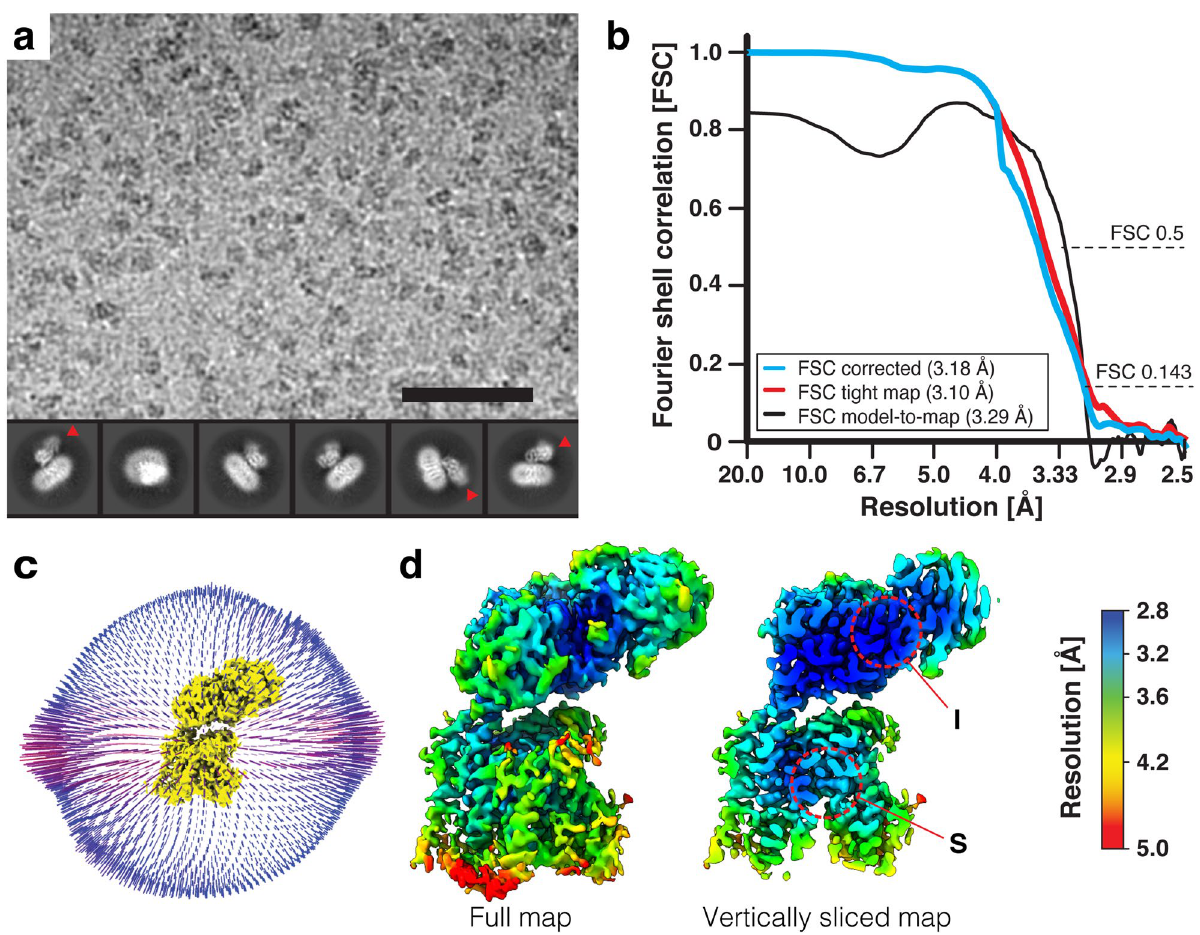
Figure 2. Cryo-EM structure determination of human 4F2hc-LAT2::D11vs. ( a ) In the upper part, a representative electron micrograph recorded at a defocus of about -1.8 μm is shown (scale bar: 50 nm). In the lower part, six selected 2D-class averages are displayed (frame size: 21 nm). Densities of D11vs in 2D-class averages of complexes viewed from the side are indicated with red arrowheads. ( b ) Plot of Fourier shell correlation (FSC) curves, experimental half-maps (FSC = 0.143 criterion) and model-to-map fit (FSC = 0.5 criterion). ( c ) Three-dimensional representation of the Euler angular distribution. The height of blue to red cylinders indicate relative representations of particle orientations. In the center of the plot, the 4F2hc- LAT2::D11vs cryo-EM map is displayed as yellow colored surface. ( d ) Full density map (left) and a vertically sliced map version (right) colored by local resolution and shown at a threshold level of 0.142. Highest resolution regions corresponding to the substrate binding pocket of LAT2 and the interface between 4F2hc-ED and D11vs are labeled with S and I, respectively. Volume representations were prepared using UCSF ChimeraX (version 1.3; see Materials and Methods). The figure was assembled and labeled using Adobe Illustrator 26.5 (https:// adobe. com/ produ cts/ illus